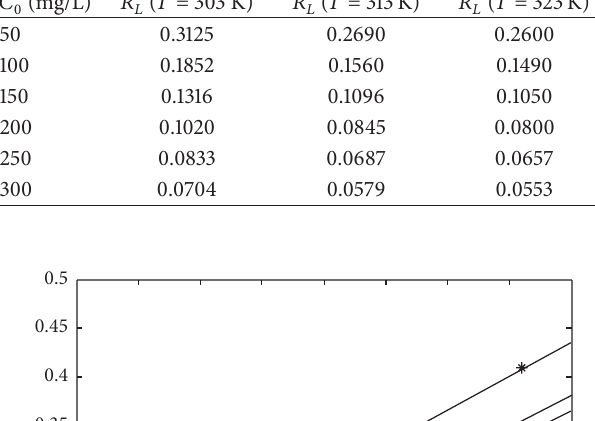
Figure 6: Effect of biosorbent mass ( 𝐶 0 : 200 mg/L; 𝑉 : 100mL; pH: 6; temperature: 30 ∘ C).